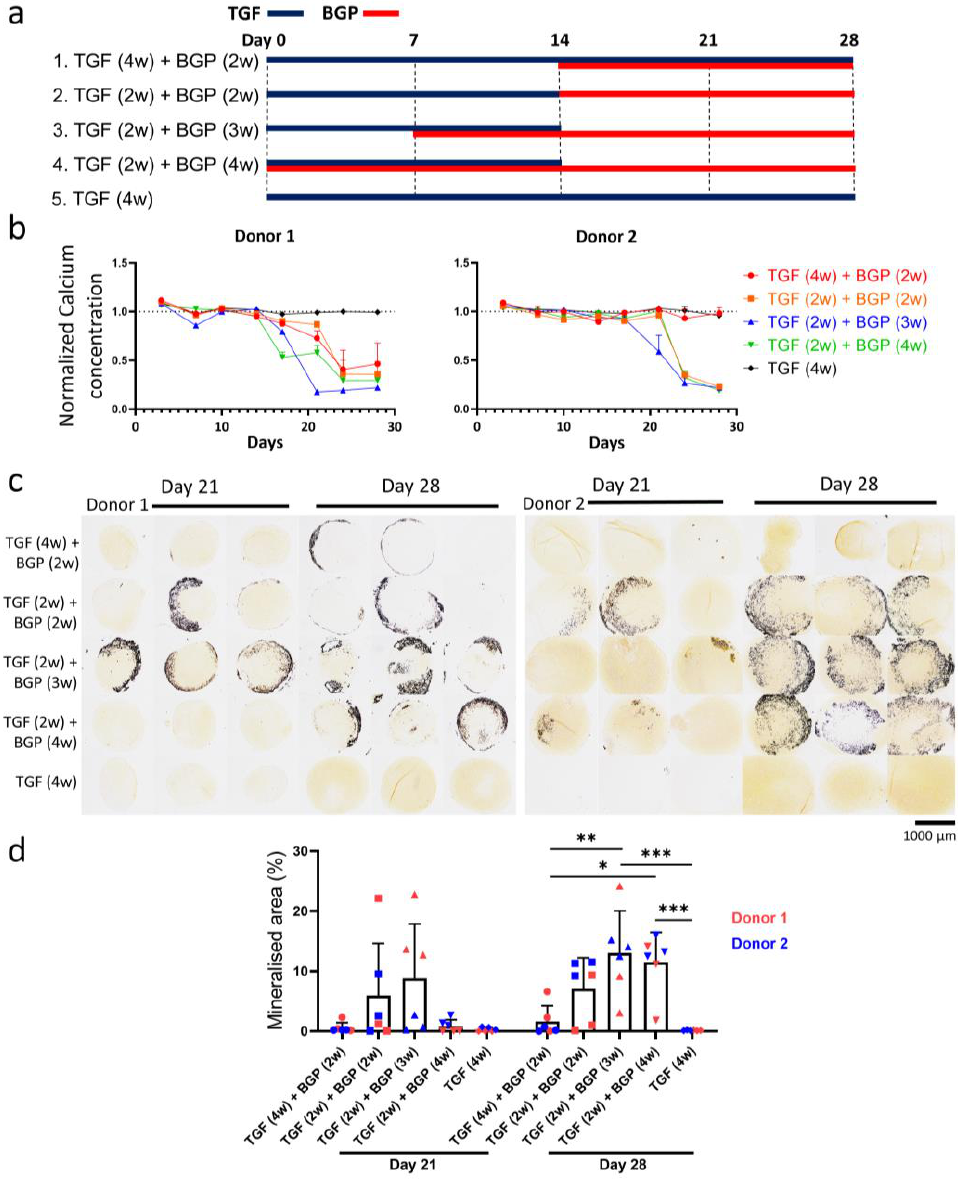
Figure 1. Sequential exposure to TGF- β and BGP leads to in vitro mineralisation of chondrogenic pellets. ( a ) Culture scheme of the different approaches to stimulate in vitro pellet mineralisation over 28 days. N = 2 hMSC donors in triplicate samples per time-point. ( b ) Longitudinal measurements of extracellular calcium levels in the culture medium to assess calcium uptake by the pellets over 28 days. Data were normalised vs. medium only and shown as average ± SD. Error bars denote standard deviation. ( c ) Von Kossa-stained histological sections of the pellets subjected to the different mineralisation protocols (3 pellets/condition from 2 hMSC donors on day 21 and 28 of culture). ( d ) Quantification of the mineralised area using Von Kossa-stained histological sections. Data are presented as average ± SD (N = 2 hMSC donors). * 0.01 < p < 0.05, ** 0.01 < p < 0.001, *** p <